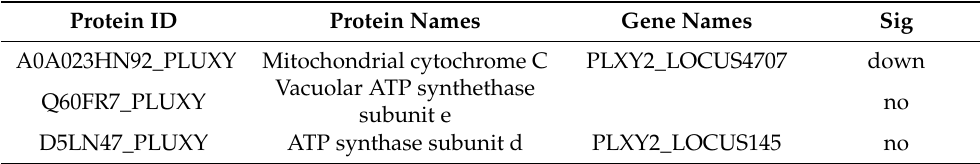
Table 4. DEPs involved in pathways of oxidative phosphorylation. Protein ID Protein Names Gene